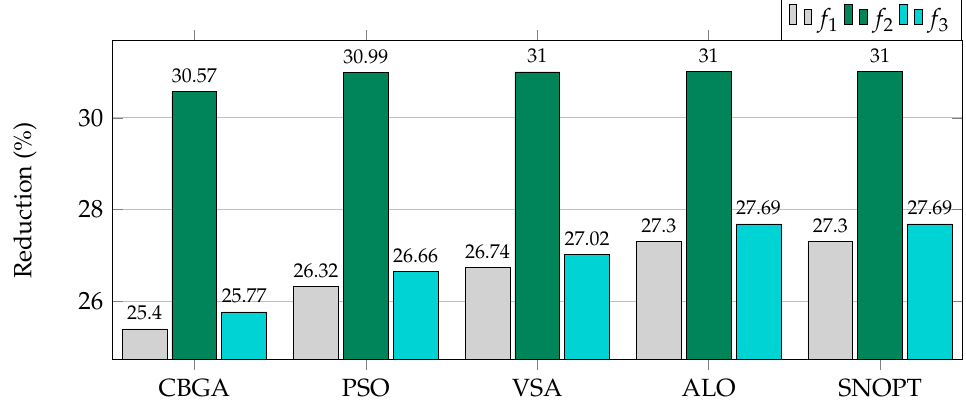
Figure 7. Reduction percentage regarding the objective functions in the IEEE 33-bus system.